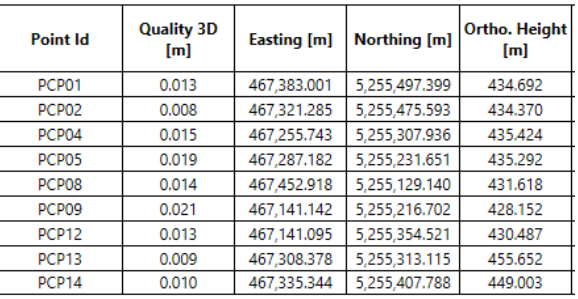
Figure 6 . Overview of the available data.